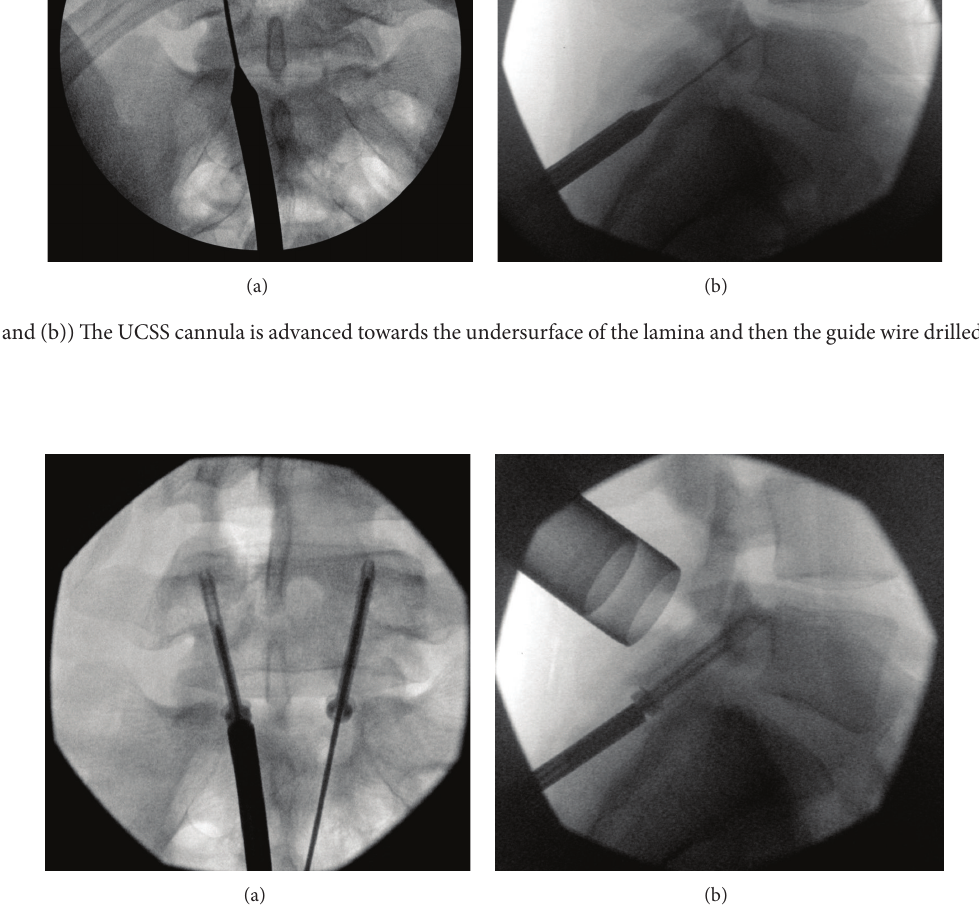
Figure 5: ((a) and (b)) Cortical partially-threaded screws are passed across the pars defect.